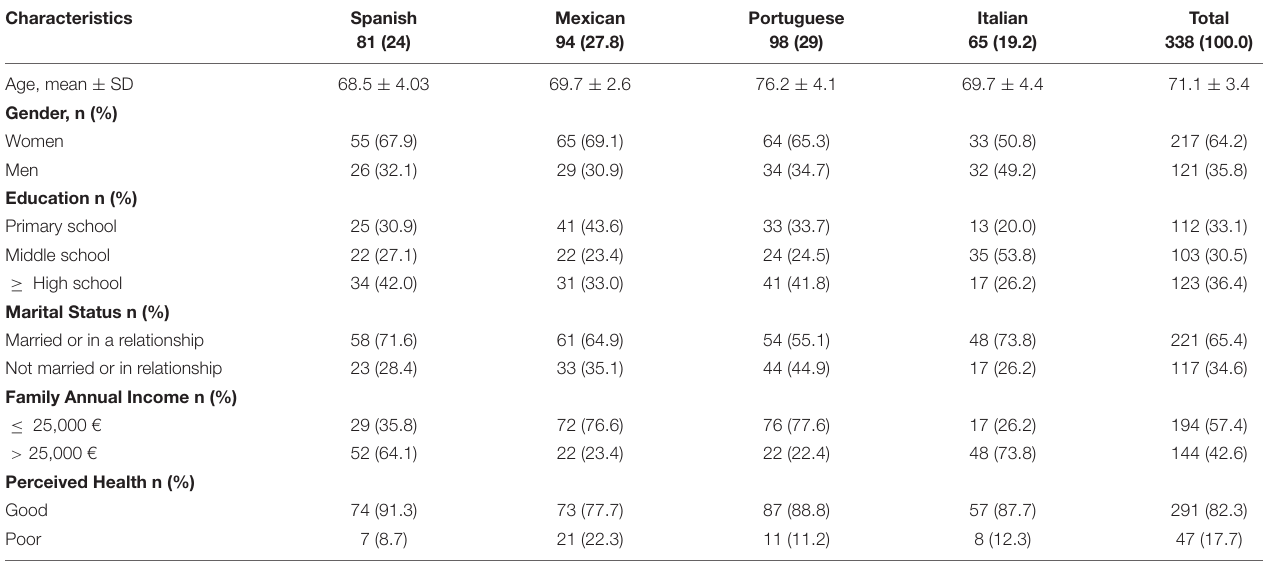
TABLE 1 | Sample socio-demographic and health